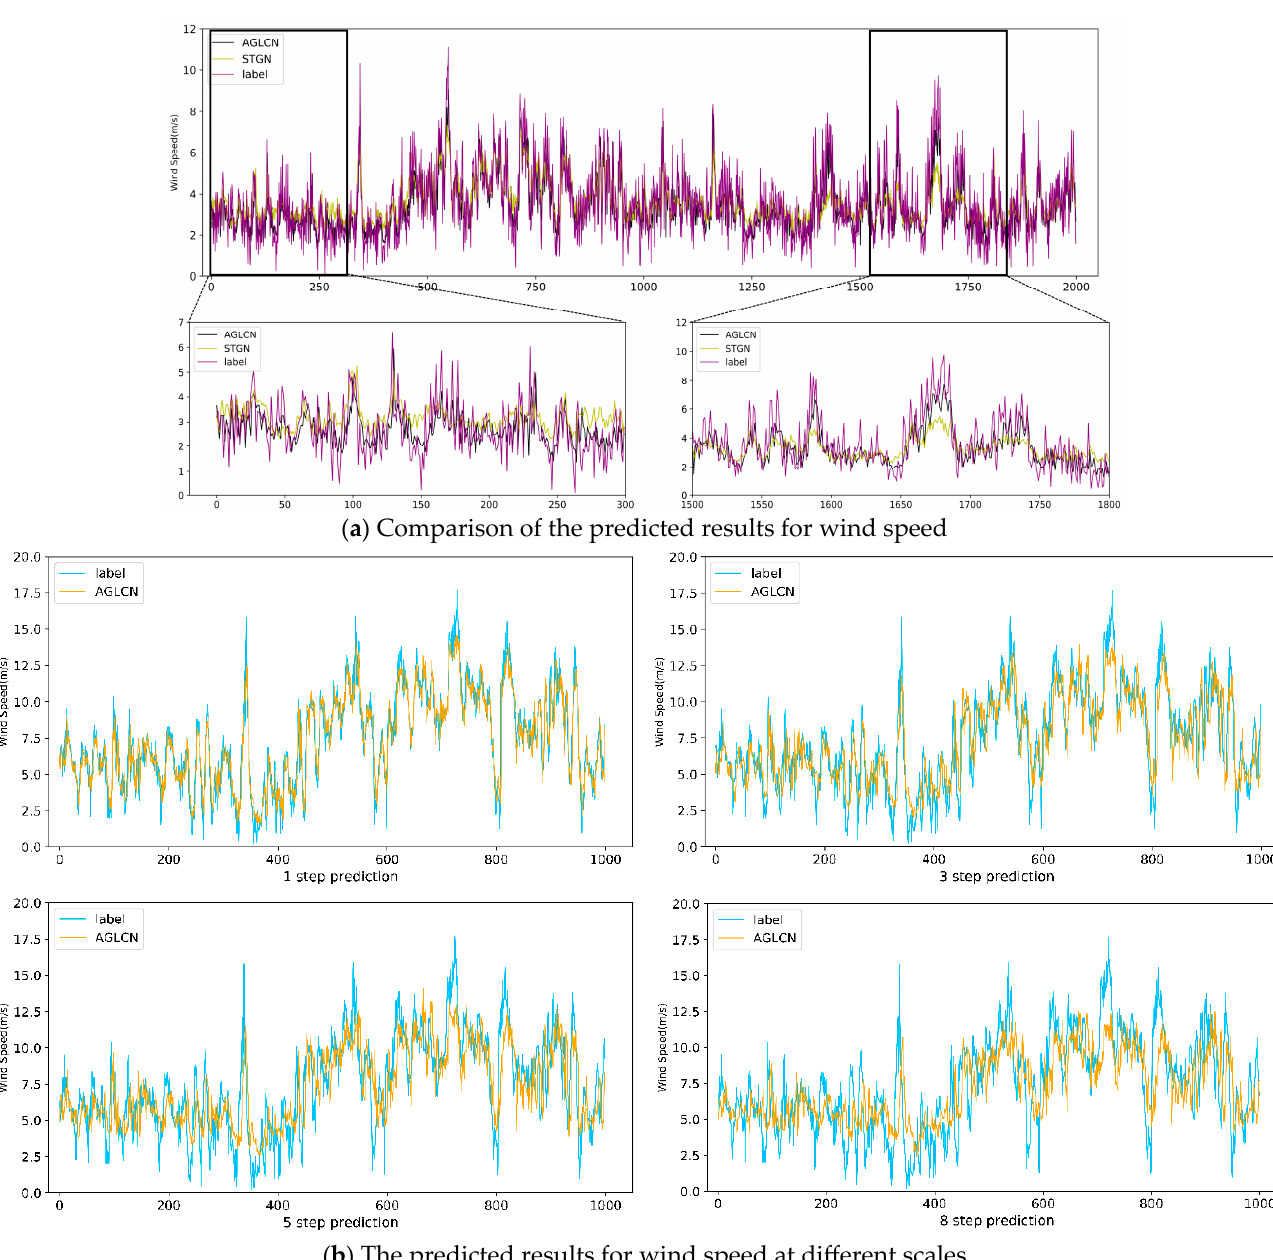
Figure 6. Visualization of the prediction results.